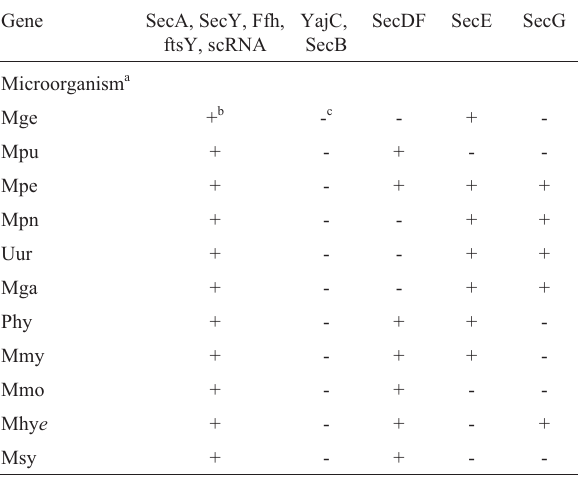
Table 3 - Sec translocon pathway secretion system components among known mycoplasma genomes. Gene SecA, SecY, Ffh, YajC, SecDF SecE SecG ftsY, scRNA SecB Microorganism